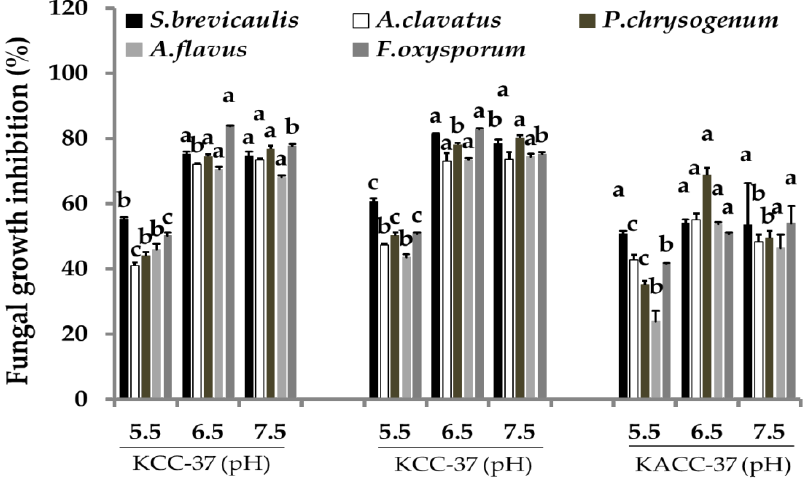
Figure 3. Effect of L. plantarum KCC-37 and L. plantarum KCC-38 CFM produced at different pH on fungal growths (% of fungi growth inhibition, compared to control.) Data represent mean ± STD of three replicates. Different letters a, b, and c within a column indicates significances differences between CFM produced at different pH ( p < 0.05).